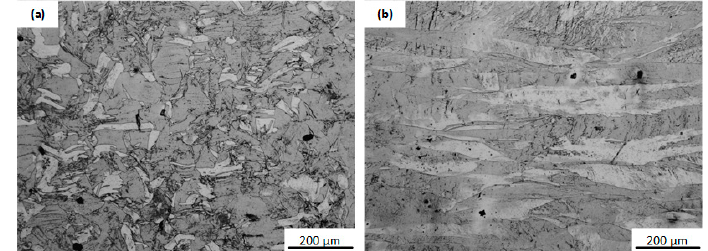
Figure 3. Microstructure of pure copper raw material and chips: ( a ) the surface perpendicular to the axial direction; ( b ) the surface parallel to the axial direction.